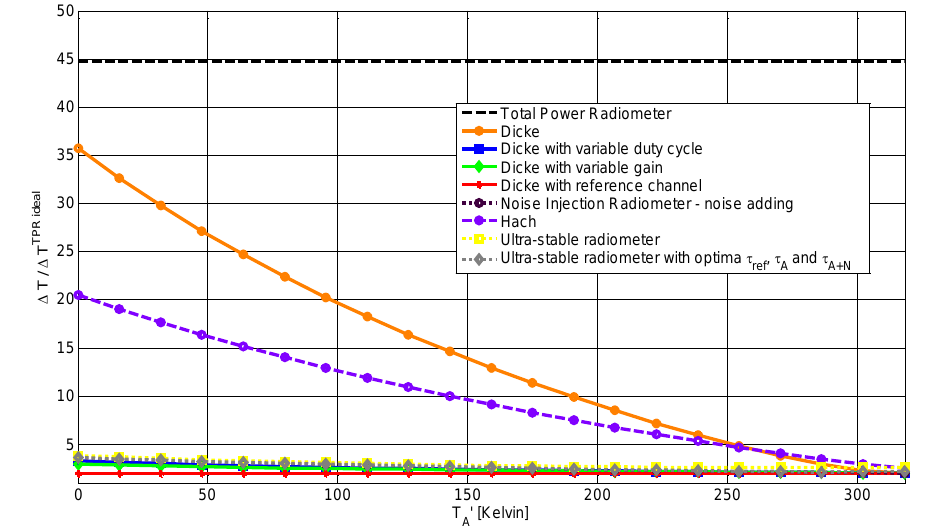
Figure 2. (a) Radiometric resolution of different types of microwave radiometers normalized to the one of an ideal total power radiometer ((1) with  G/G = 0) with  G/G = 0.01, T = 400 K, T = 318 K, T = 318 K, T = 393 K, T = 913 K, R REF 1 2 ON T = 30 K, B = 20 MHz,  = 1 s,  = 1 s, (b) Zoom of Figure 2(a). OFF AGC